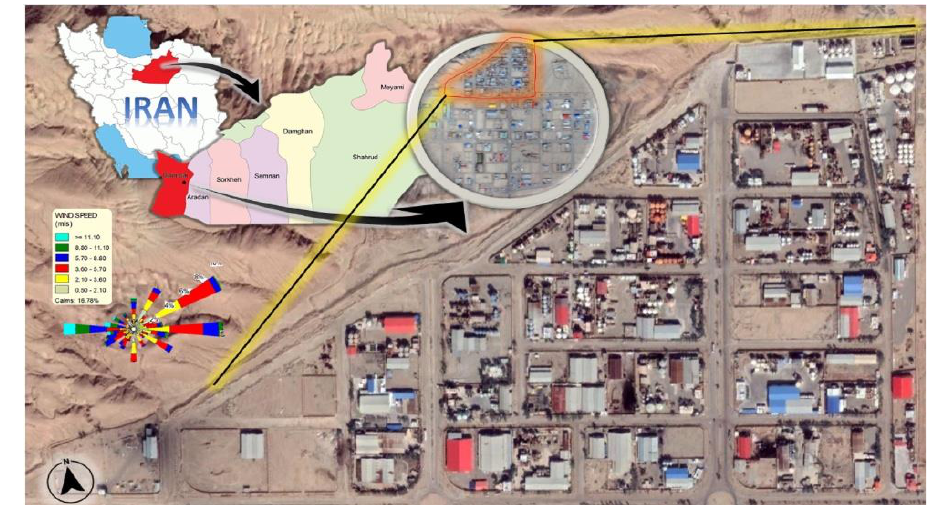
Fig. 1. Map of Garmsar city and location of secondary oil refineries